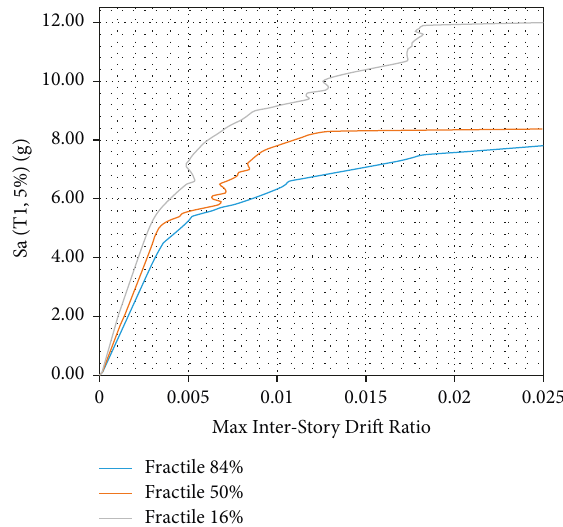
Figure 26: Fractile curves of the glulam braced portal frame.